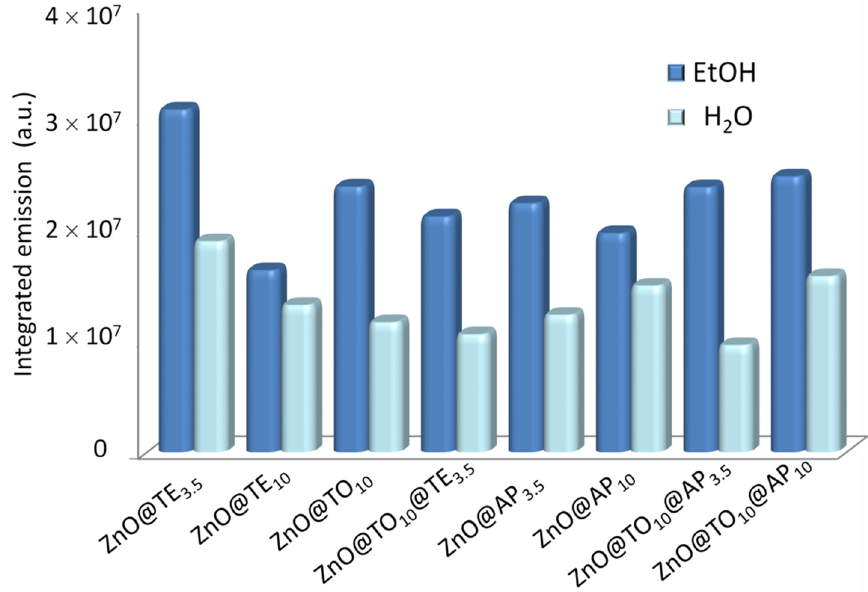
Figure 3. Integrated fluorescence emission as function of silane coupling, the combination of silanes, and their concentration.